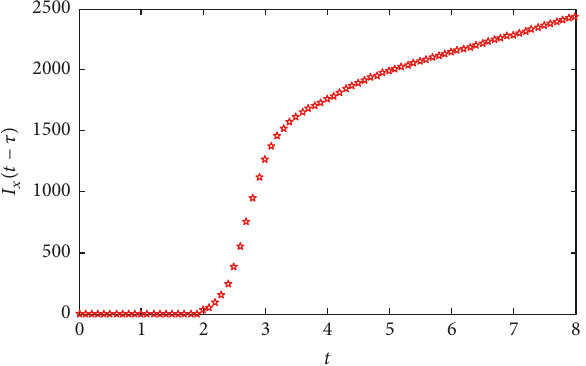
Figure 7: The approximate solutions 𝐼 𝑥 (𝑡 − 𝜏) with 𝜏 = 2 , 𝛼 = 0.98 using NSFDM.